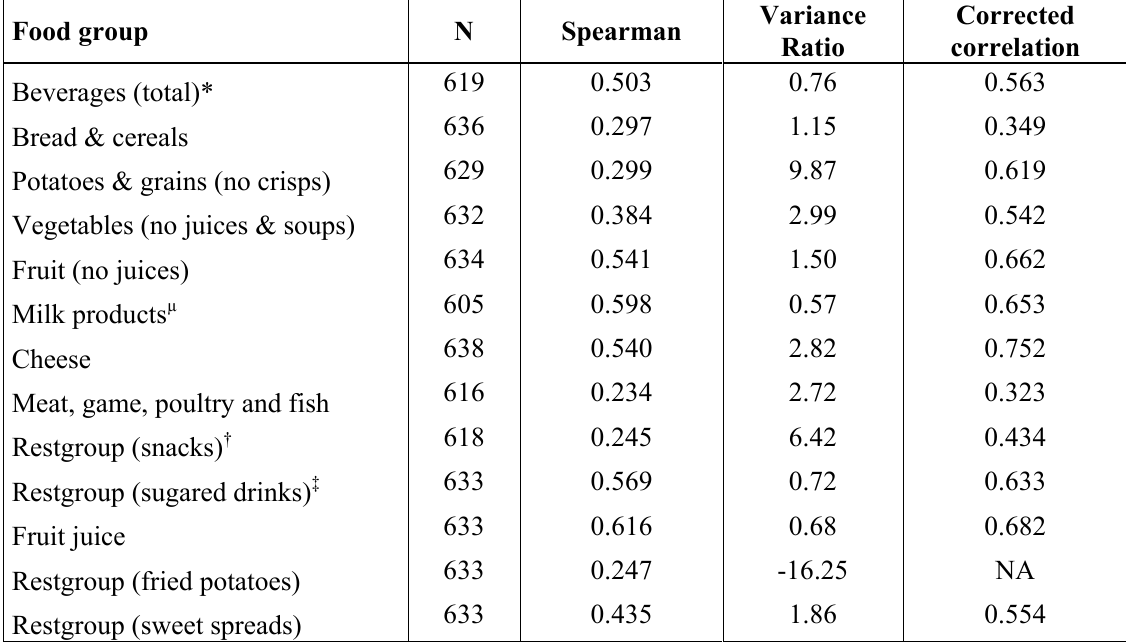
Table 5. Spearman correlations between FFQ and EDR for food (group) intakes. Food